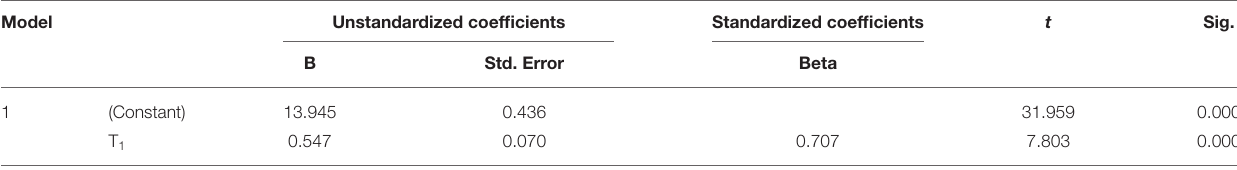
TABLE 7A | The relations between emotional valence and test scores (coefficients a )-T 1 .